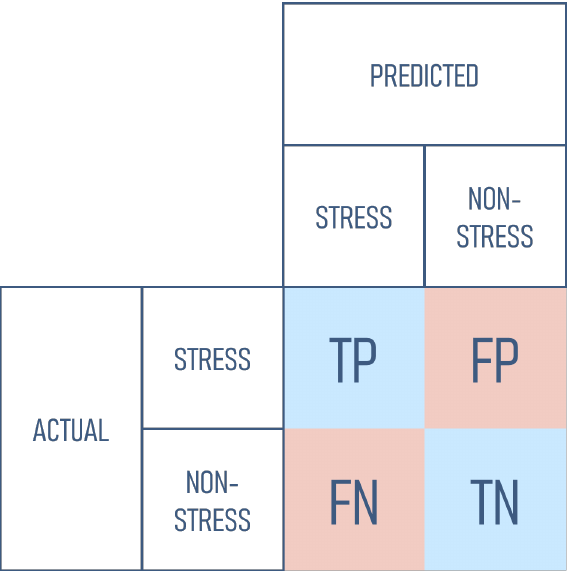
Figure 4. Confusion Matrix. Blue square means the data are correctly predicted while red square means the data are incorrectly